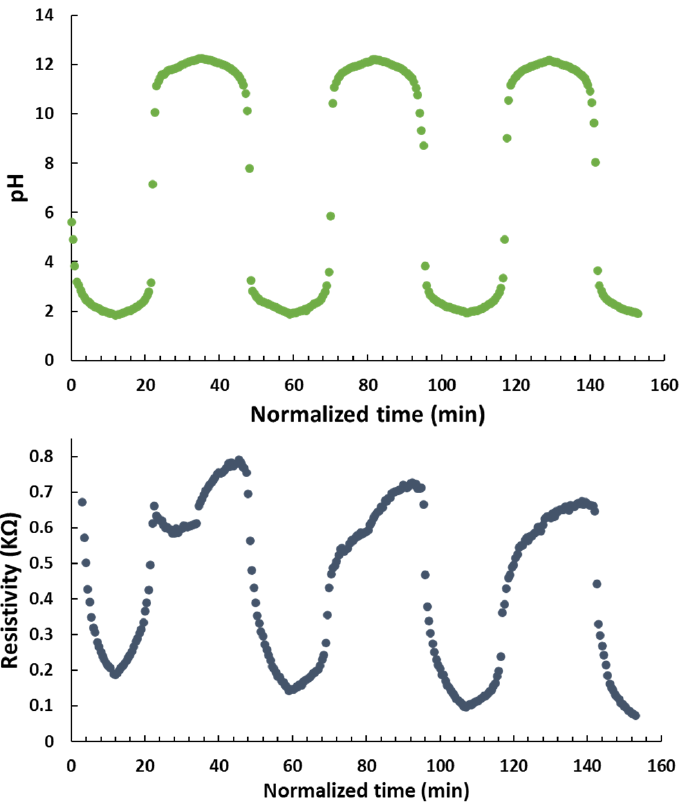
Figure 6. Changes in resistivity as a function of pH over time in the PANI/rGO/P1 sample.